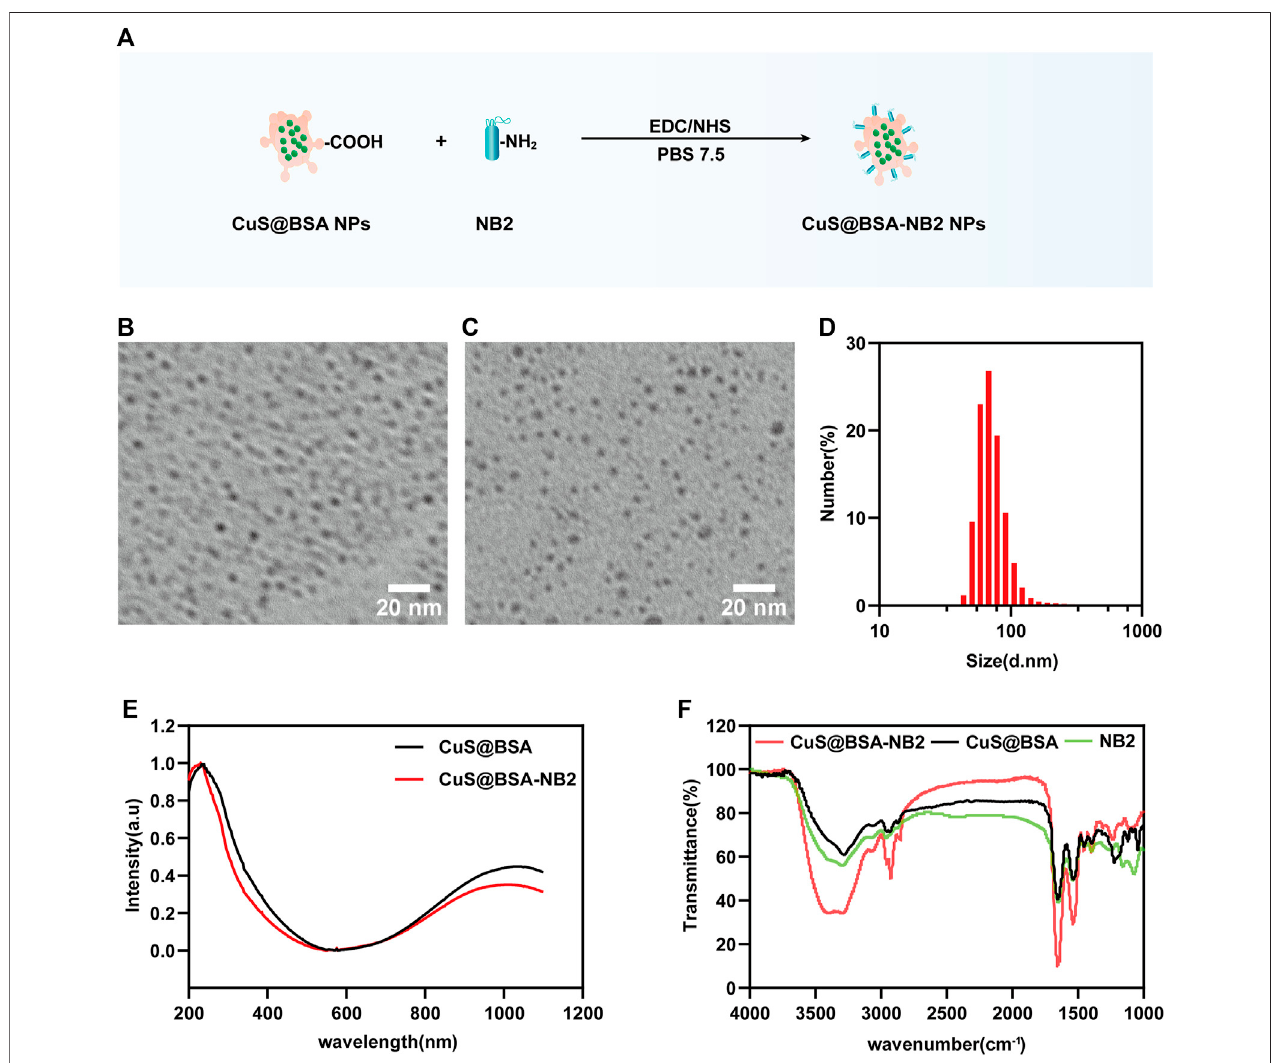
FIGURE 3 | Characterization of nanoparticles. (A) Schematic diagram of the process of biosynthesis of CuS@BSA-NB2 NPs. (B) TEM image of CuS@BSA NPs, and the scale bar was 20 nm. (C) TEM image of CuS@BSA-NB2 NPs, and the scale bar was 20 nm. (D) DLS analysis of CuS@BSA-NB2 NPs. (E) UV-vis absorption curves of CuS@BSA NPs and CuS@BSA-NB2 NPs. (F) Fourier infrared spectrum absorption curves of CuS@BSA, CuS@BSA-NB2 and